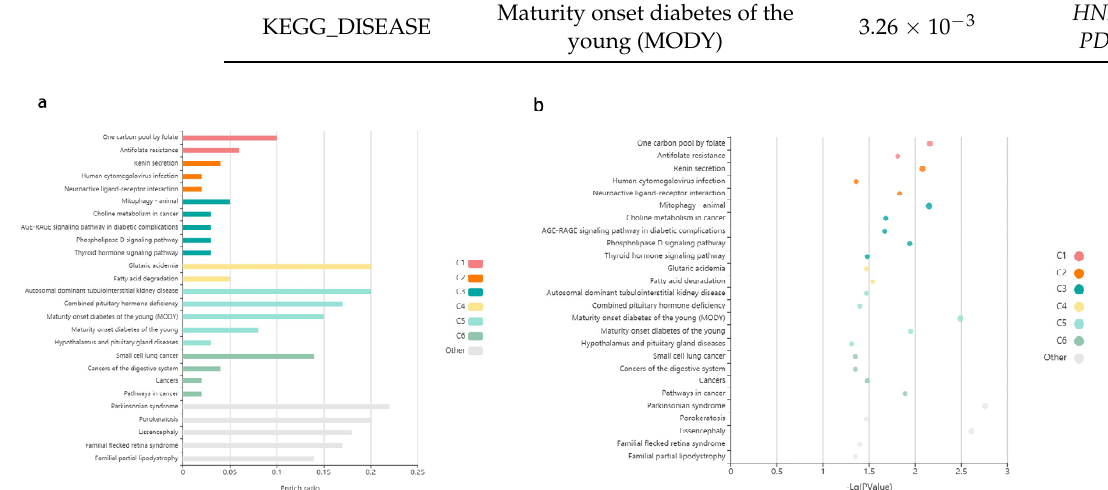
Figure 2. The enriched KEGG pathways of differentially methylated genes. ( a ) The enriched KEGG pathways of differentially methylated genes visualized in the bar plot. Each row represents an enriched function, and the length of the bar represents the enrich ratio, which is calculated as “input gene number”/” background gene number”. The color of the bar (C1–C6) represents different clusters, the terms in the same cluster have the similar functions. For each cluster, if there are more than 5 terms, the top 5 with the highest enrich ratio will be displayed. The enrichment analysis was conducted using KOBAS. ( b ) The enriched KEGG pathways of differentially methylated genes visualized in bubble plot. Each bubble represents an enriched function, and the size of the bubble from small to large: (0.05,1), (0.01,0.05), (0.001,0.01), (0.0001,0.001), (1 × 10 − 10 , 0.0001), (0, 1 × 10 − 10 ). The color of the bubble (C1–C6) is the same as the color of the bar, which represents different clusters. For each cluster, if there are more than 5 terms, the top 5 with the highest enrich ratio will be displayed. The enrichment analysis was conducted using